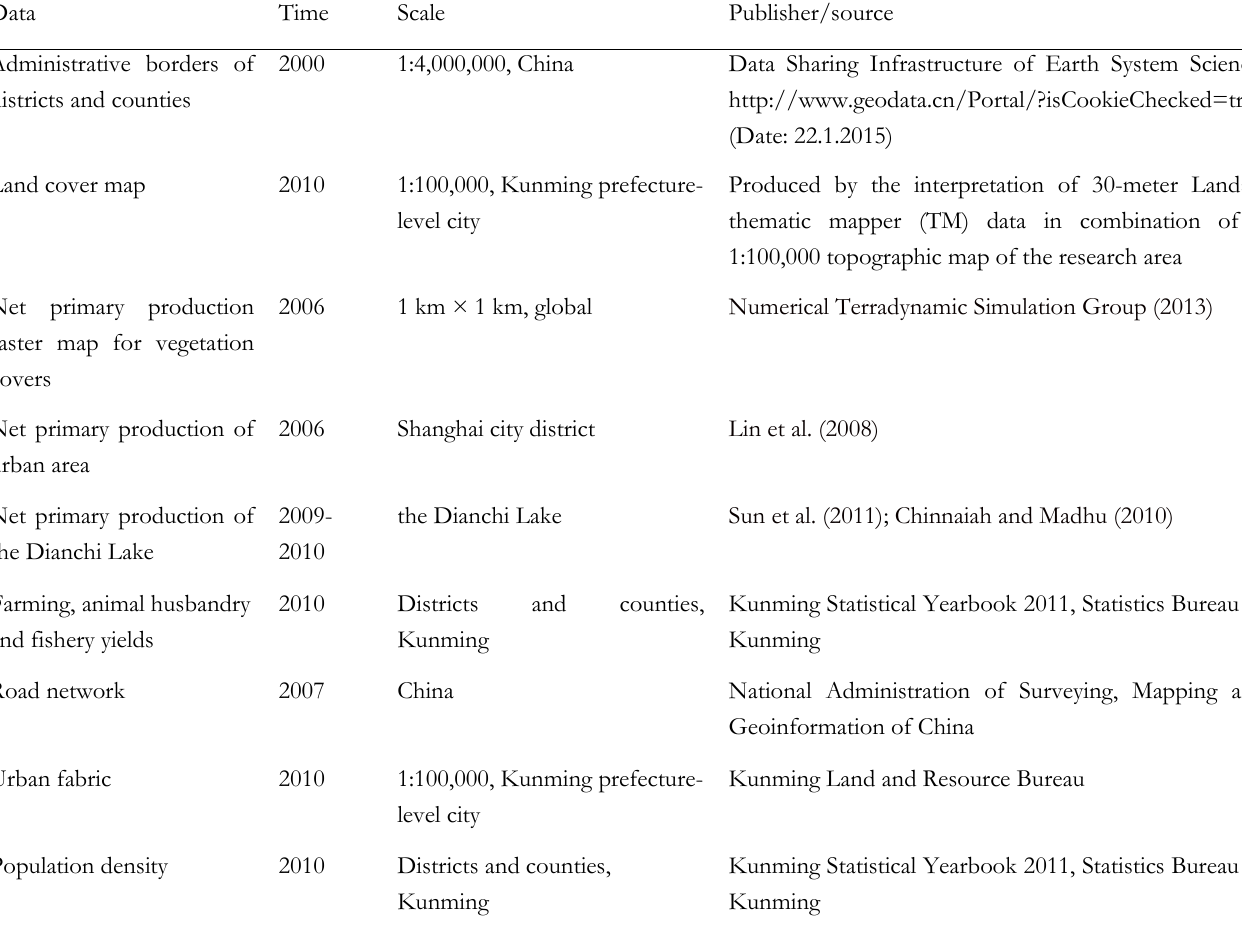
Table 5: Date uses, time, scales and sources for the study of Kunming urban-rural area 1